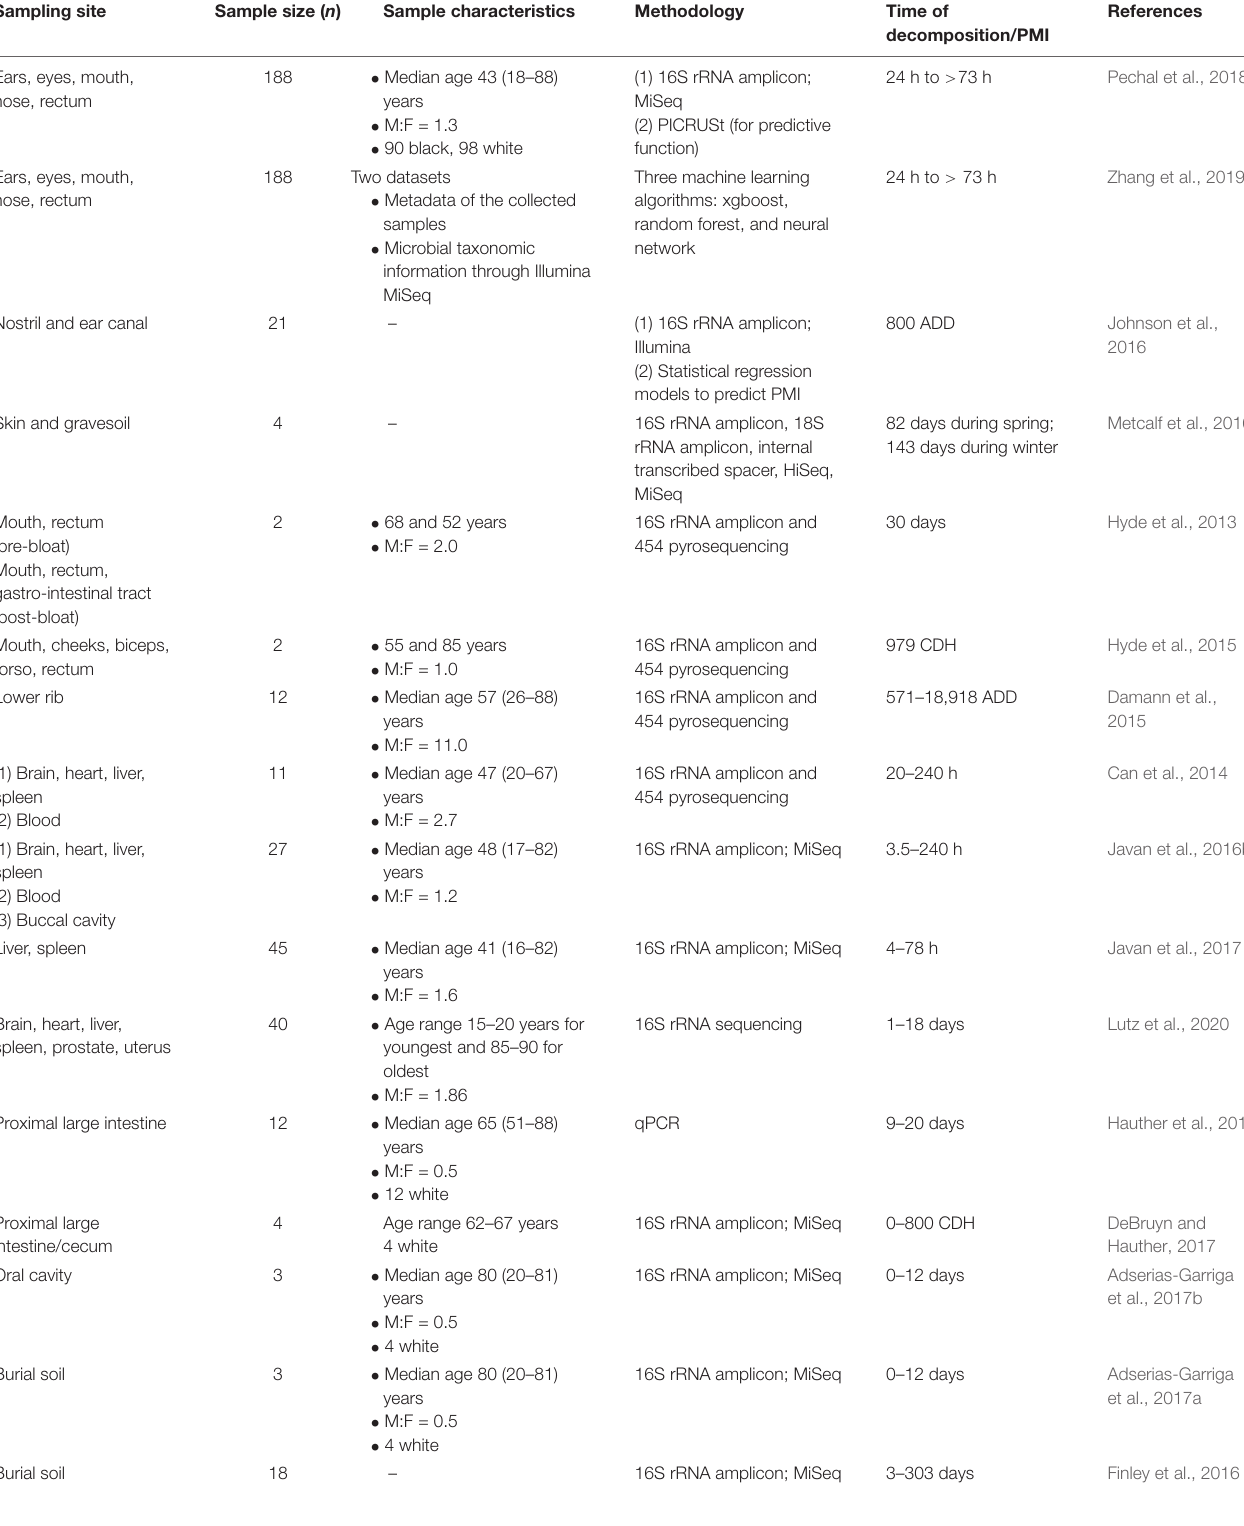
TABLE 2 | Assessment of human thanatomicrobiome in estimation of time since